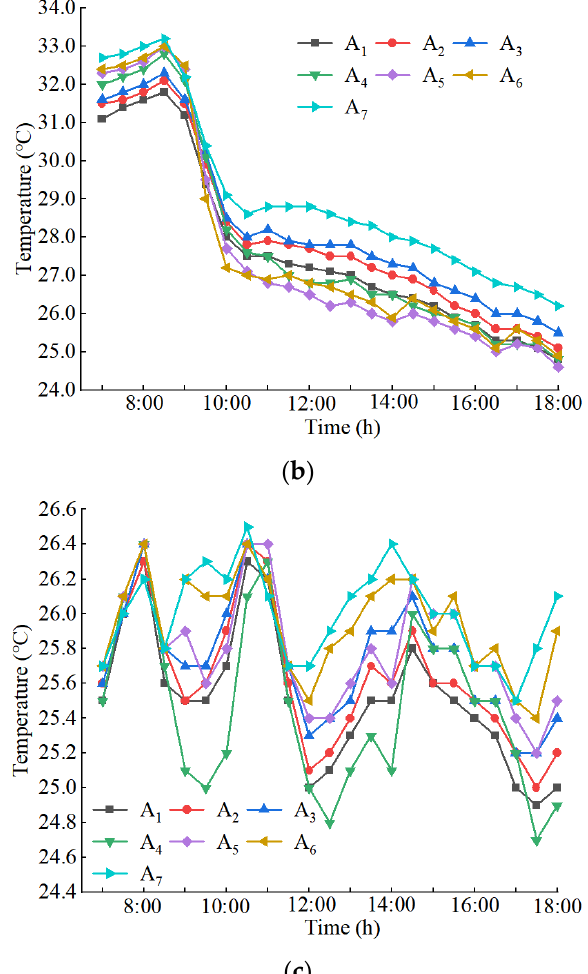
Figure 10. Vertical temperature differences under the ( a ) LH, ( b ) HL, and ( c ) MM operating strate- gies.